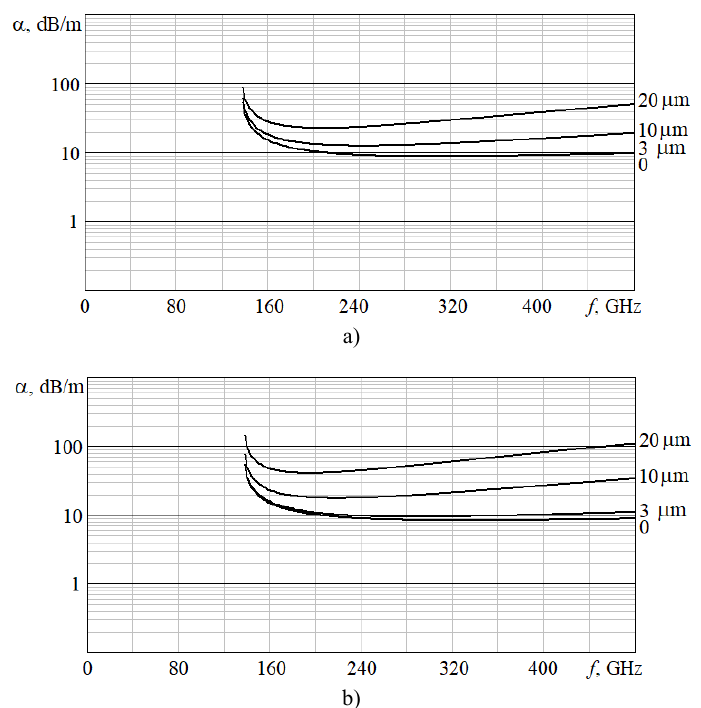
Fig. 8. Dependence on the frequency of losses per unit length in a rectangular waveguide 1,1 х 0,55 mm with smooth profile а ) m = 0,5 and m = 60, b) m =